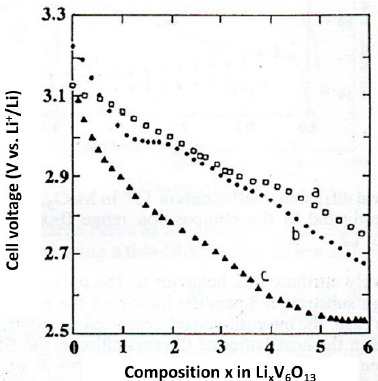
Figure 13. Discharge profiles vs. lithium uptake for Li // V 6 O 13 thin-film microbatteries. Active cathode films were grown with: ( a ) T s = 250 ◦ C, as-deposited; ( b ) T s = 250 ◦ C, annealed at 300 ◦ C in Ar; ( c ) T s = 25 ◦ C, annealed at 300 ◦ C in Ar.